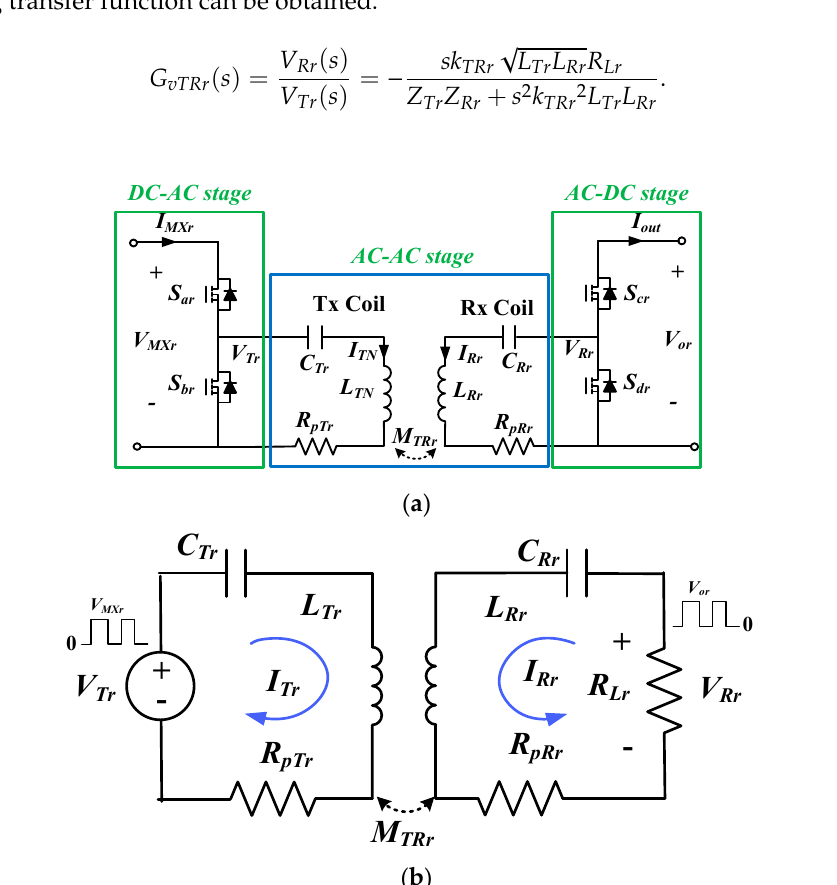
Figure 5. Circuit diagram of the wireless power transfer (WPT) stage in the WEDES system ( a ) equivalent circuit and ( b ) T-model.